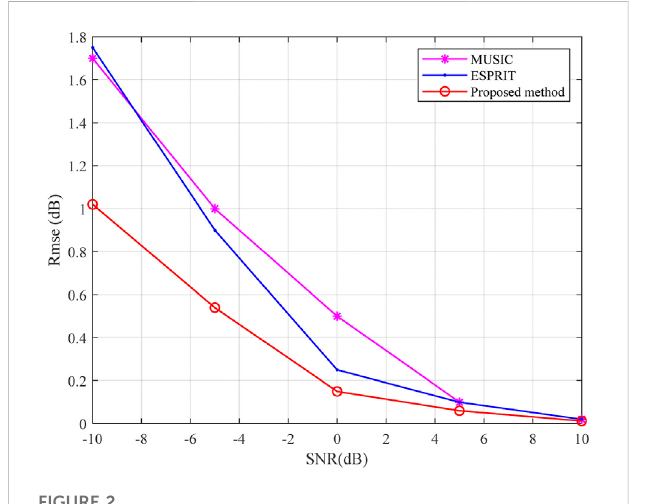
FIGURE 2 DOD estimation performance with different SNR.